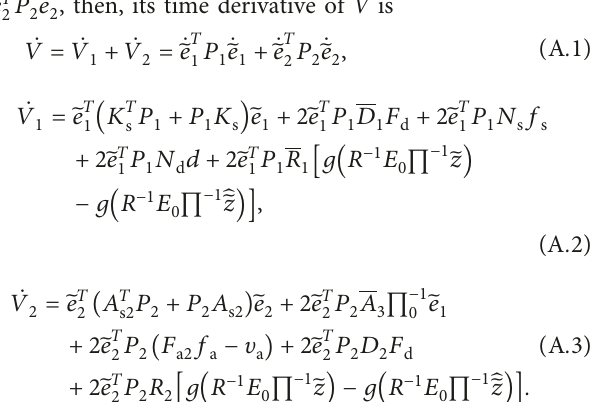
internal leakage caused by seal wear. Figure 6 shows the fluctuations in residuals exceeding the dynamic threshold with alarm signal. To conduct the fault state of the flow reduction through the servo valve due to blockage, the maximum displacement of the proportional valve spool was set as 95% of the normal state. When the spool of the proportional valve is blocked or stuck, the fault detection system could detect this fault and send out an alarm signal. The experimental results are shown in Figure 7.